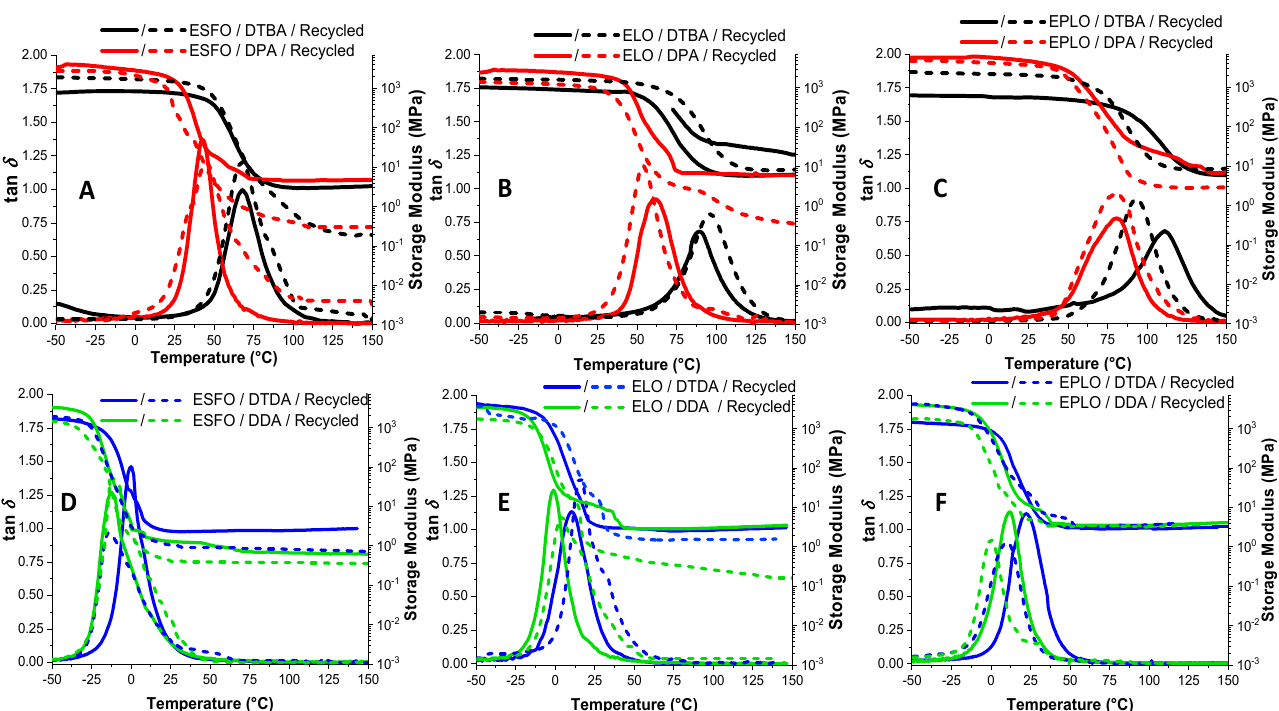
Figure 6. Evolution of tan δ with temperature for the virgin and recycled EVOs thermosets obtained with aromatic ( A – C ) or aliphatic ( D – F ) crosslinkers. Table 3. Properties of the virgin and recycled